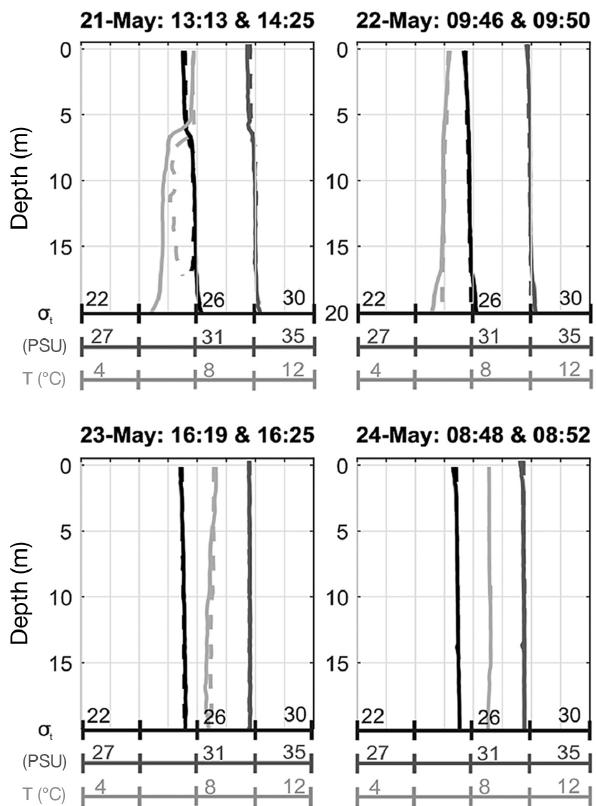
Fig. 4. Water density ( σ t ), salinity (PSU) and temperature (°C) measured by the CTD at Soløya outside the fish cage in position A 2 (solid line) (see Fig. 1 for details), and inside the fish cage at position A 1 (dashed line). The time stamps above each graph represent the time the measurement was started outside and inside for each date, respectively direction of the current at Soløya is more diffuse than that at Fornes, which showed a clear main direction.